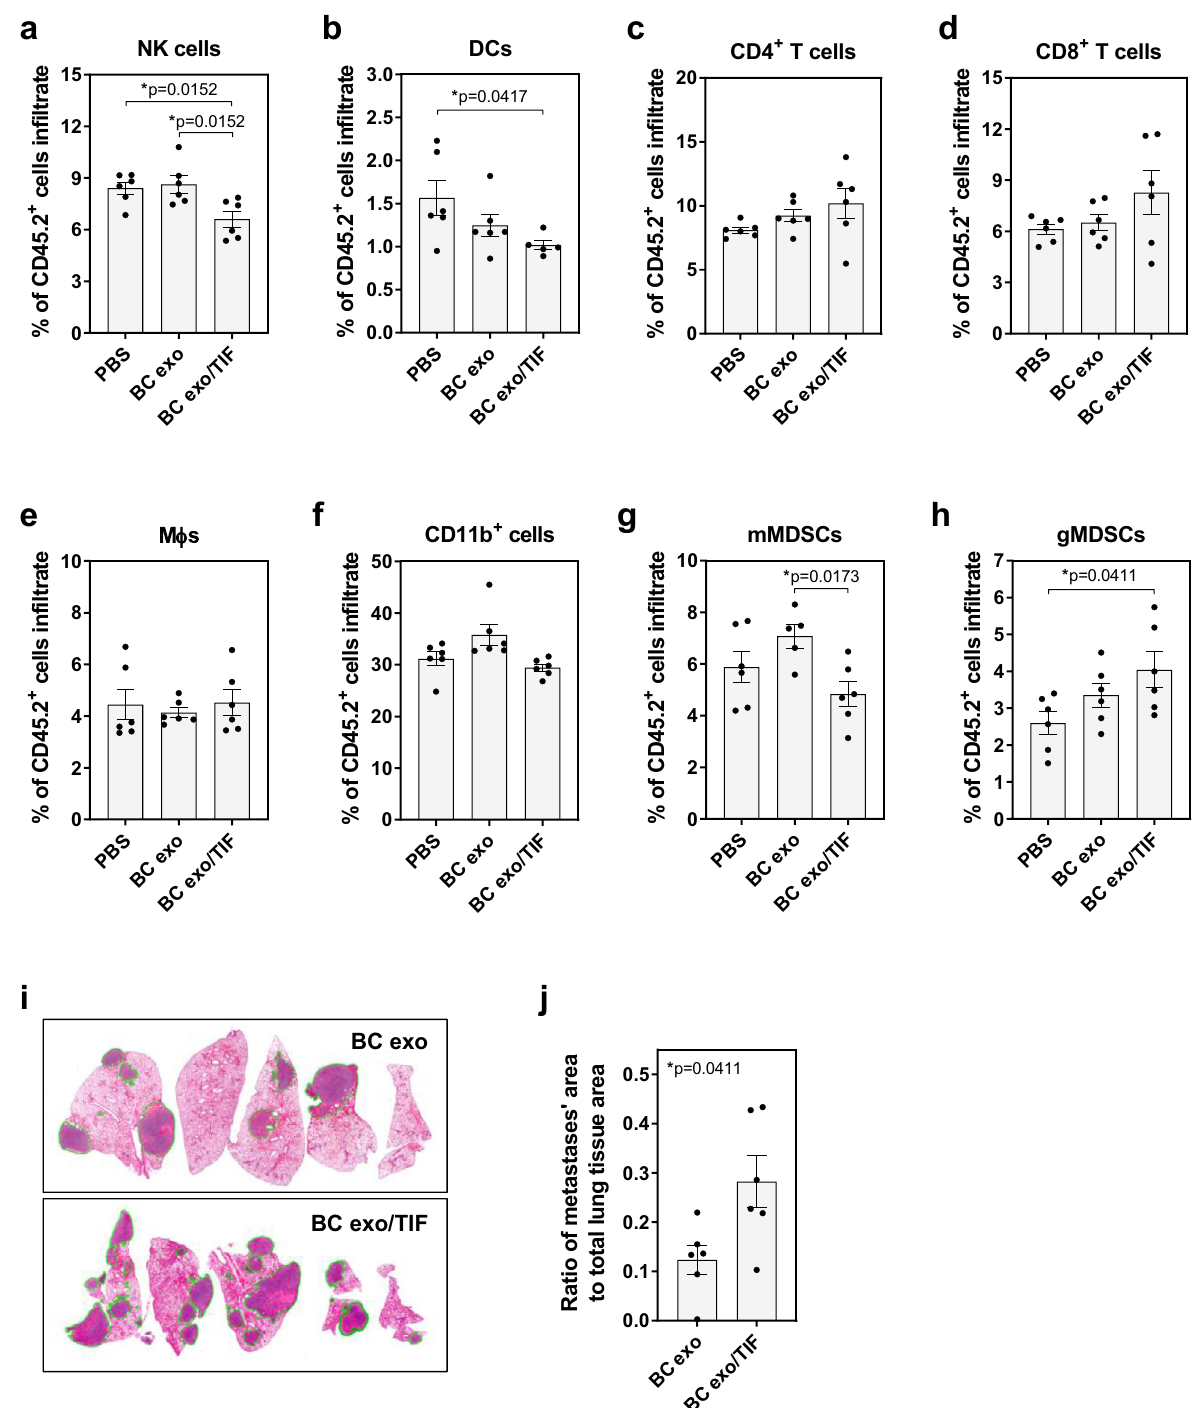
Fig. 3 Cytokine-bound exosomes create a cancer-permissive environment to enhance metastasis. C57Bl/6 WT mice were injected with cell culture- derived EO771 exosomes, previously incubated (BC exo/TIF) or not (BC exo) with TIF, every 48 h, three times. PBS only-injected mice served as negative controls ( n = 6 animals/group). a – h Frequency of distinct CD45.2 + immune cell subsets in the lung: a NK cells (CD3 − NK1.1 + ), b dendritic cells (DCs; CD11c + MHCII + ), c CD4 + T cells (CD3 + CD4 + ), d CD8 + T cells (CD3 + CD8 + ), e macrophages (M ɸ ; CD11b + F4/80 + ), f myeloid cells (CD11b + ), g mMDSCs (CD11b + Ly6C hi Ly6G − ), and h gMDSCs (CD11b + /Ly6C lo /Ly6G + ) as assessed by fl ow cytometry. i , j Mice pre-conditioned with cell culture- derived EO771 exosomes previously incubated (BC exo/TIF) or not (BC exo) with TIF received a single i.v. injection of EO771 cells, and metastatic burden in the lung was assessed ( n = 6 animals/group). i Representative lung sections of each group (H&E staining; metastatic area outlined in green). j Ratio of metastases ’ area to total lung tissue area (each data point represents a different mouse; one section was examined per mouse; all fi ve lobes were analyzed and combined to determine metastases ’ and total lung tissue areas per section). Data are presented as mean ± SEM. * p < 0.05, as analyzed by two-tailed Mann – Whitney U